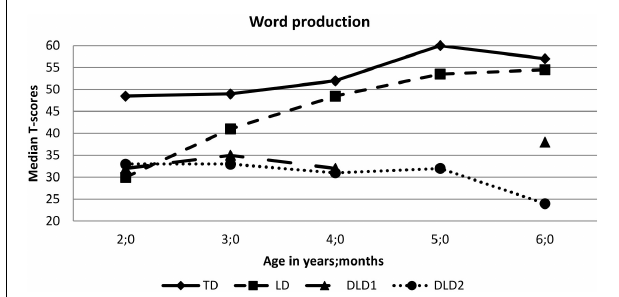
FIGURE 6 | Performances in the word production tasks of children with TD ( n = 29–32), children with a LD at 2;0 ( n = 6–8) and two children with a DLD (DLD1 and DLD2) between 2;0 and 6;0.